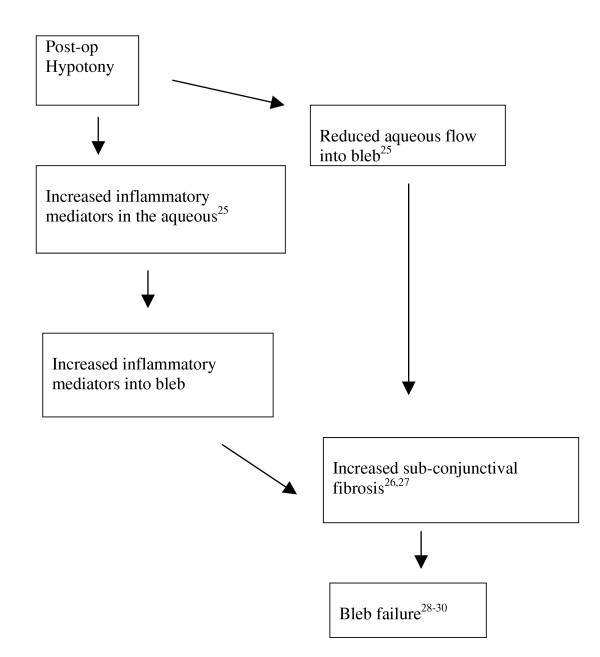
Flow diagram of the suggested pathogenesis of bleb failure after hypotony.